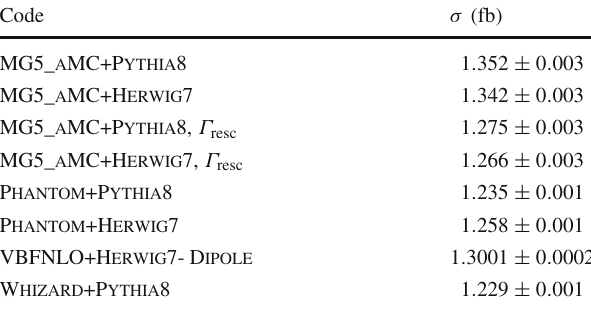
Table 6 Cross sections at LO+PS accuracy. The MG5_aMC results with Γ resc are rescaled to account for the effect related to the W-boson widthcomputedby MadSpin (seethetextfordetails).Theuncertainties shown refer to estimated statistical errors of the Monte Carlo integra- tions Code σ ( fb )